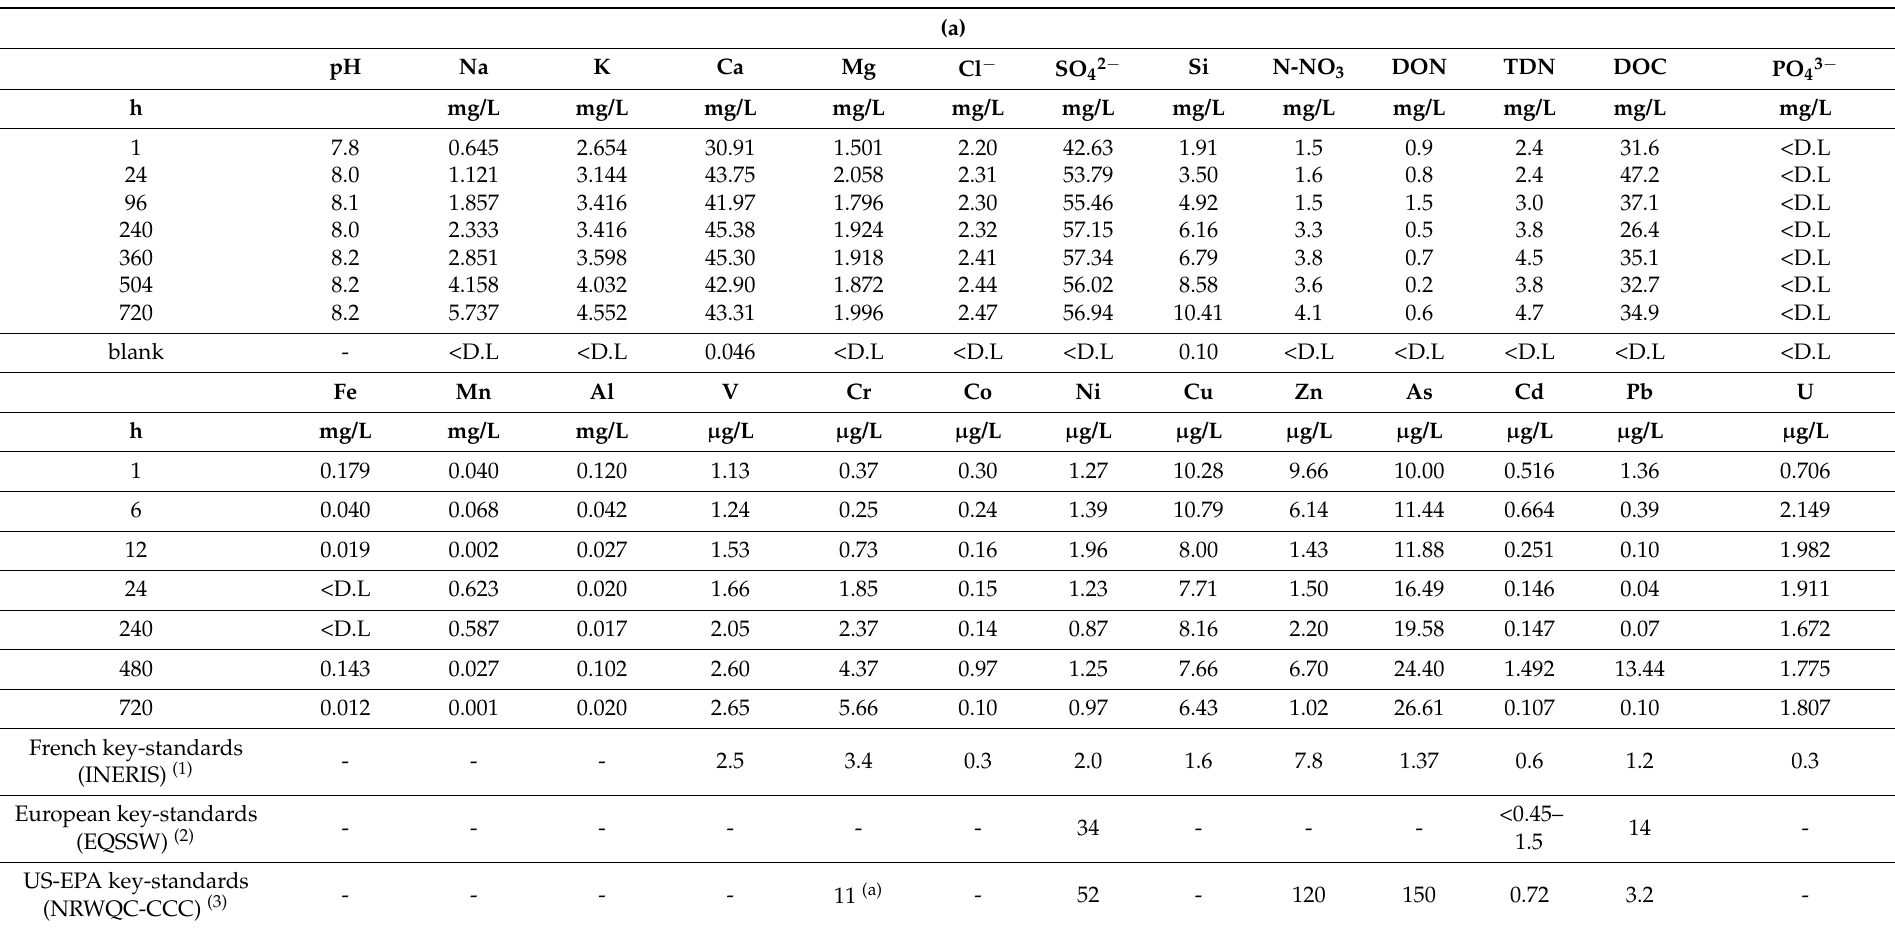
Table 4. Changes over time of the chemical composition of the leachate during ( a ) aerobic and ( b ) anaerobic batch experiments of a representative surface sediment of the Xiangjiang River